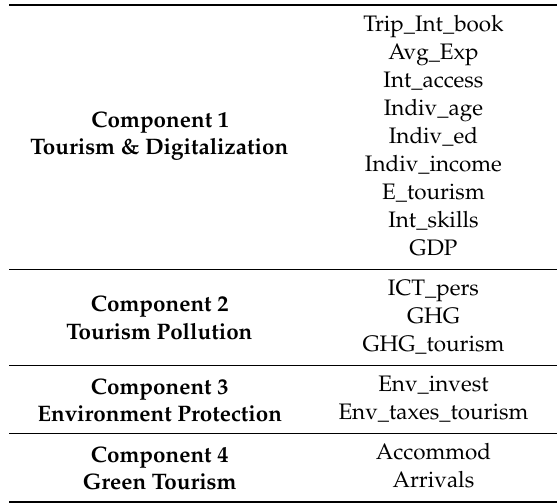
Table 5. The four main